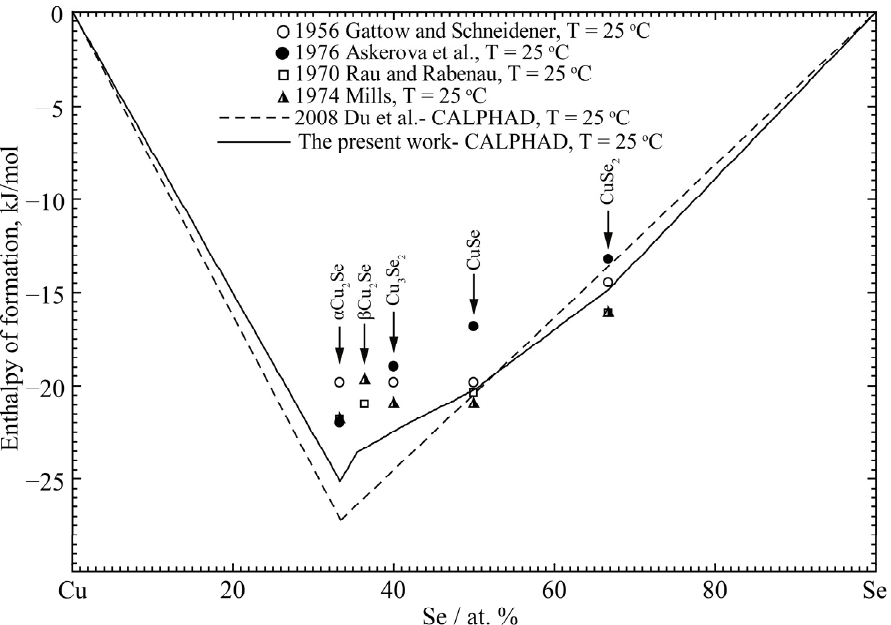
Figure 8. The calculated standard enthalpy of formation at 25 °C in the Cu-Se system compared with the experimental data from refs. [92–95] and previously optimized results by Du et al. [100].